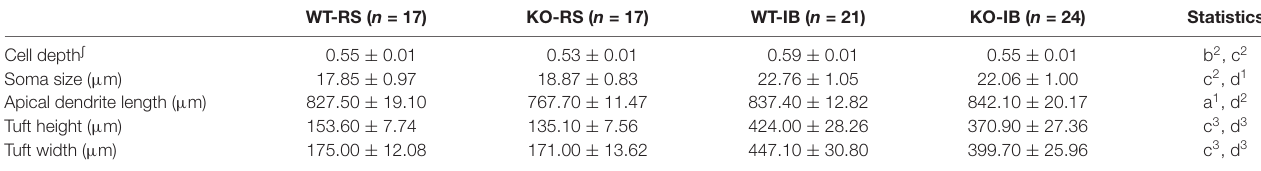
TABLE 4 | Morphological characteristics of layer V pyramidal